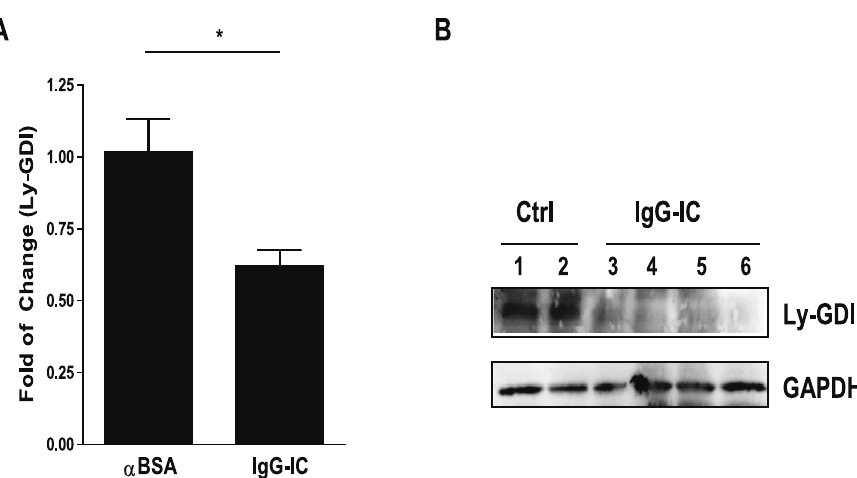
Fig 1. Ly-GDI expression in the lung is decreased by IgG immune complex challenge. (A) Whole lung RNAs were extracted 4 h after pulmonary deposition of IgG immune complexes, and subjected to reverse transcription. Real-time PCR was performed to examine the expression of Ly-GDI and GAPDH. Data were expressed as means ± S. E. M. N = 4 mice for each group. * indicated statistically significant difference- p < 0.05. (B) Total proteins obtained from control or IgG immune complex-challenged lungs were subjected to Western blot by using goat anti-Ly-GDI antibodies. The level of GAPDH was shown at the bottom as a loading